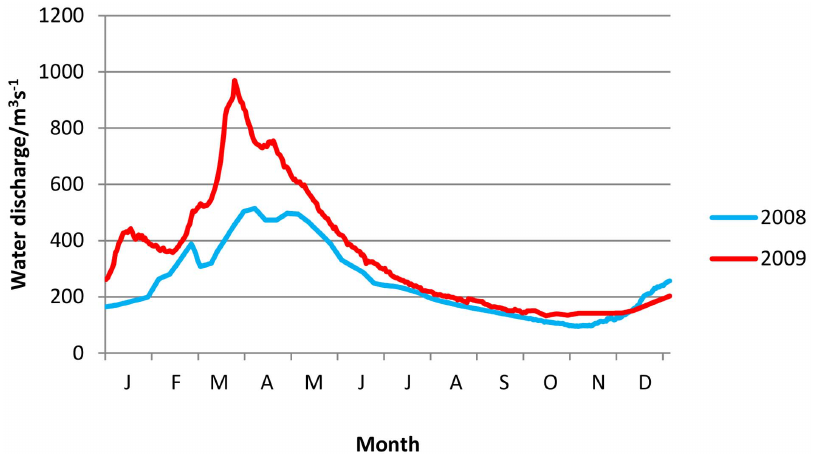
Figure 1. Water discharge from Okavango River between January 2008 and December 2009 at Mohembo. Redrawn with permission from data collected by the Okavango Research Institute (www.okavangodata.ub.bw).